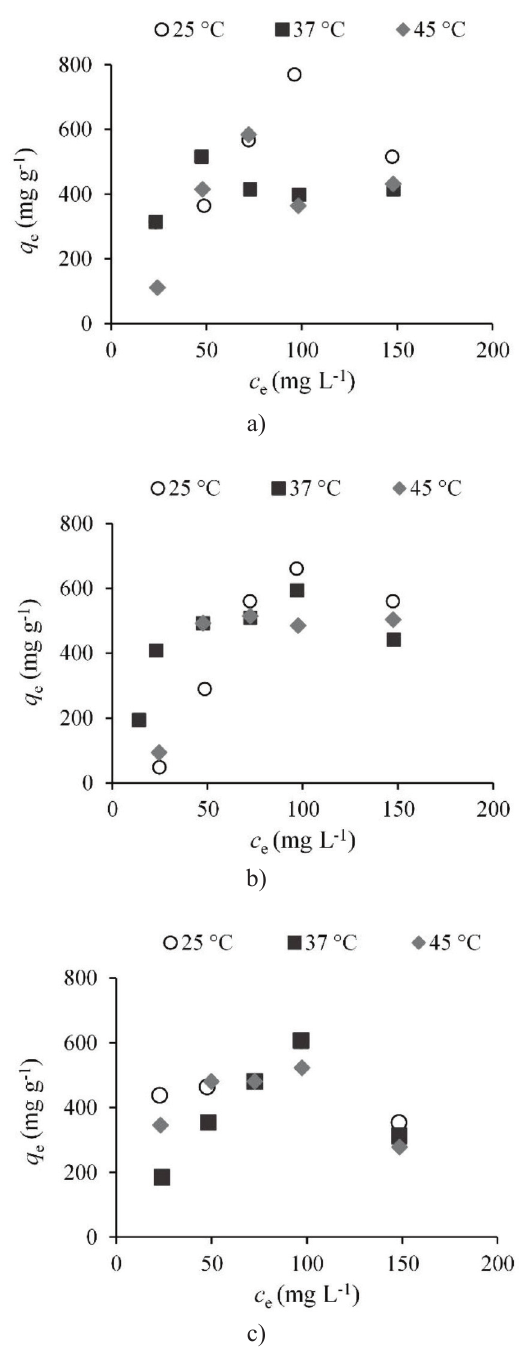
vs c diagrams) at Fig. 3 – Data for adsorption isotherms (q e e pH 1.5, 5.5 and 10 (37 °C). Data shown are means ± standard deviation of means. a) p-coumaric acid; b) caffeic acid; c) chlorogenic